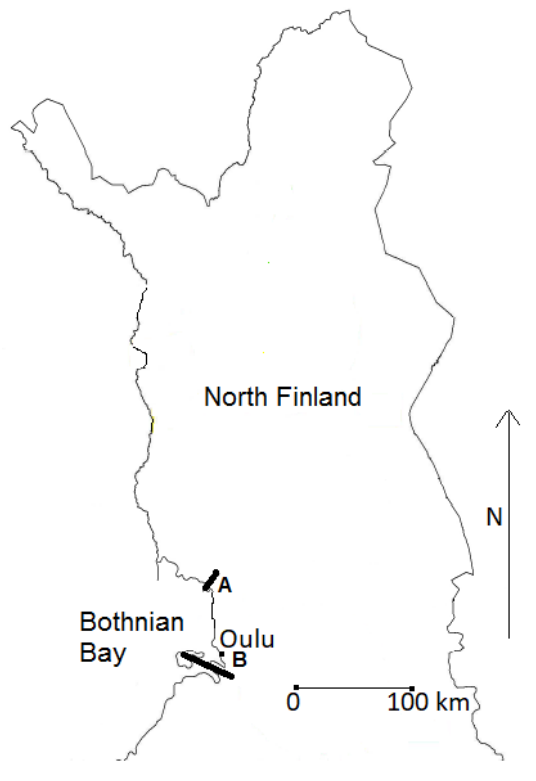
Figure 1. Outline map of northern Finland showing the location of the study area. A: sites in moraine topography; B: sites in sandy